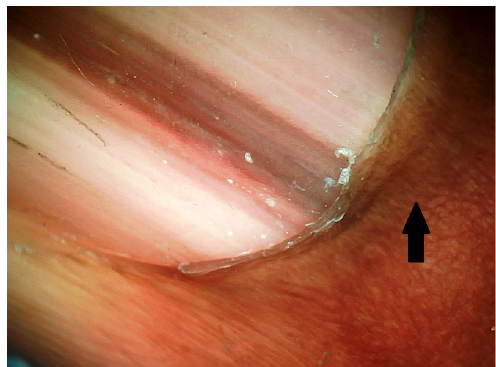
Figure 6. Dermoscopic image of a finger nail showing uniformly pigmented parallel linear band of pigmentation with pseudo- Hutchinson sign (black arrow). (Escope Videodermoscope, 20×, polarized